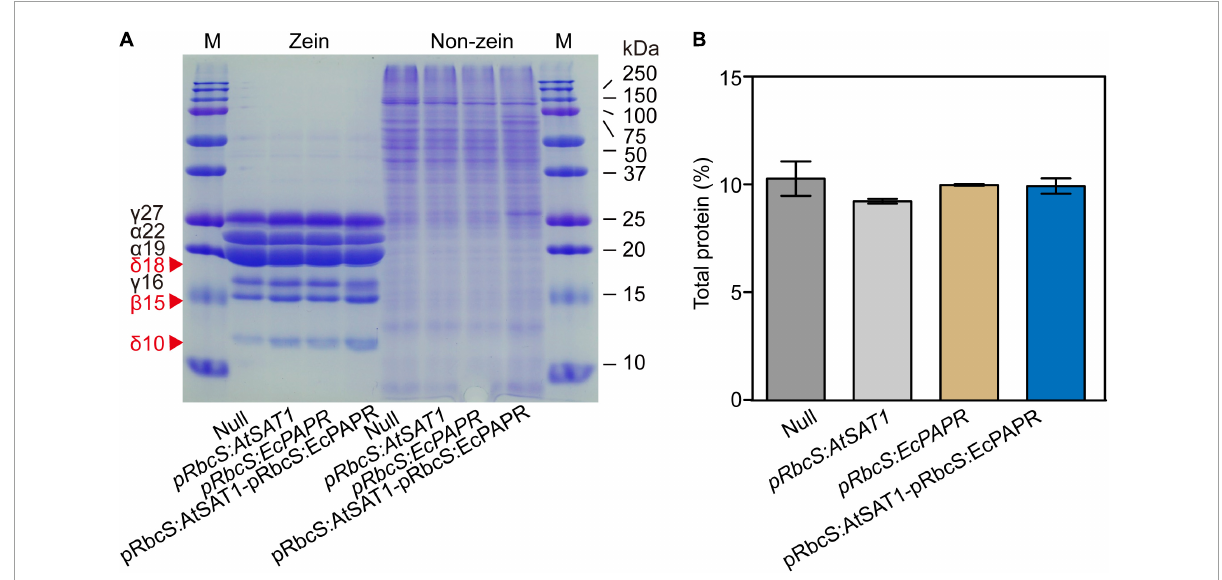
FIGURE3 Zein and non-zein accumulation pattern in transgenic kernels. (A) Kernels from Null, pRbcS:AtSAT1 , pRbcS:EcPAPR , and pRbcS:AtSAT1-pRbcS:EcPAPR were harvested from field plants. The kernels were fully mature, and protein profiles from three different kernels are shown. Protein from 300 µ g dry weight of endosperm sample was loaded in each lane. The mass of each zein is indicated to the right of the figure. (B) Total protein of mature dry seeds.